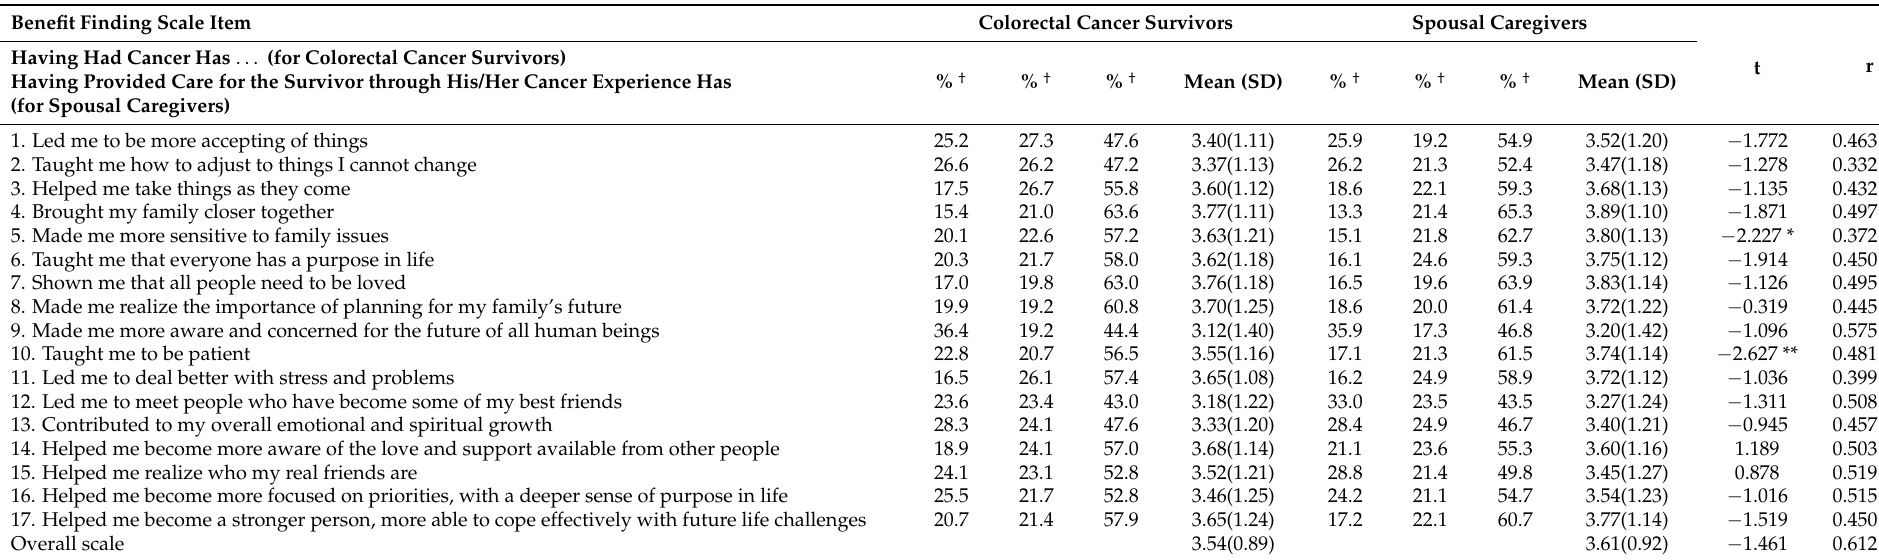
Table 4. Percentage of participants reporting growth experience in 17-item level, mean values, paired samples differences, and Pearson correlations between colorectal cancer survivors and spousal caregivers in 17-item Benefit Finding Scale ( n =